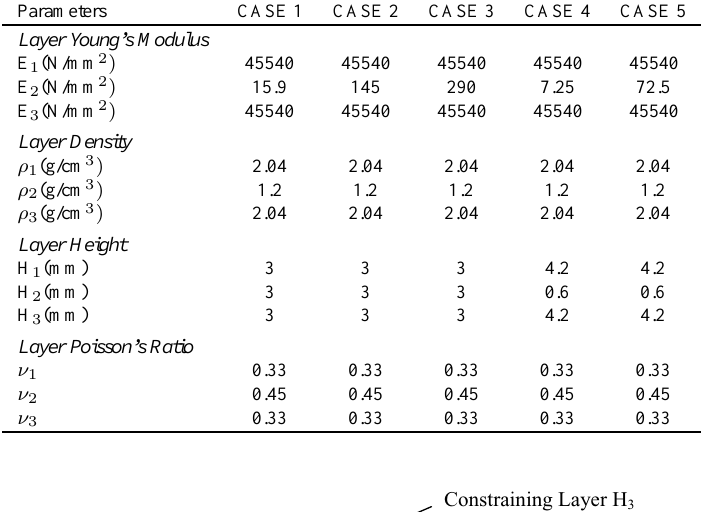
Table 1 Parameters for the verification under different cases from [5]